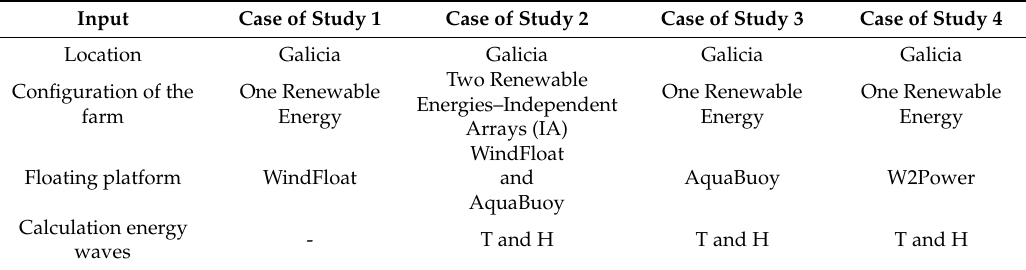
Table 5. Characteristics of the case